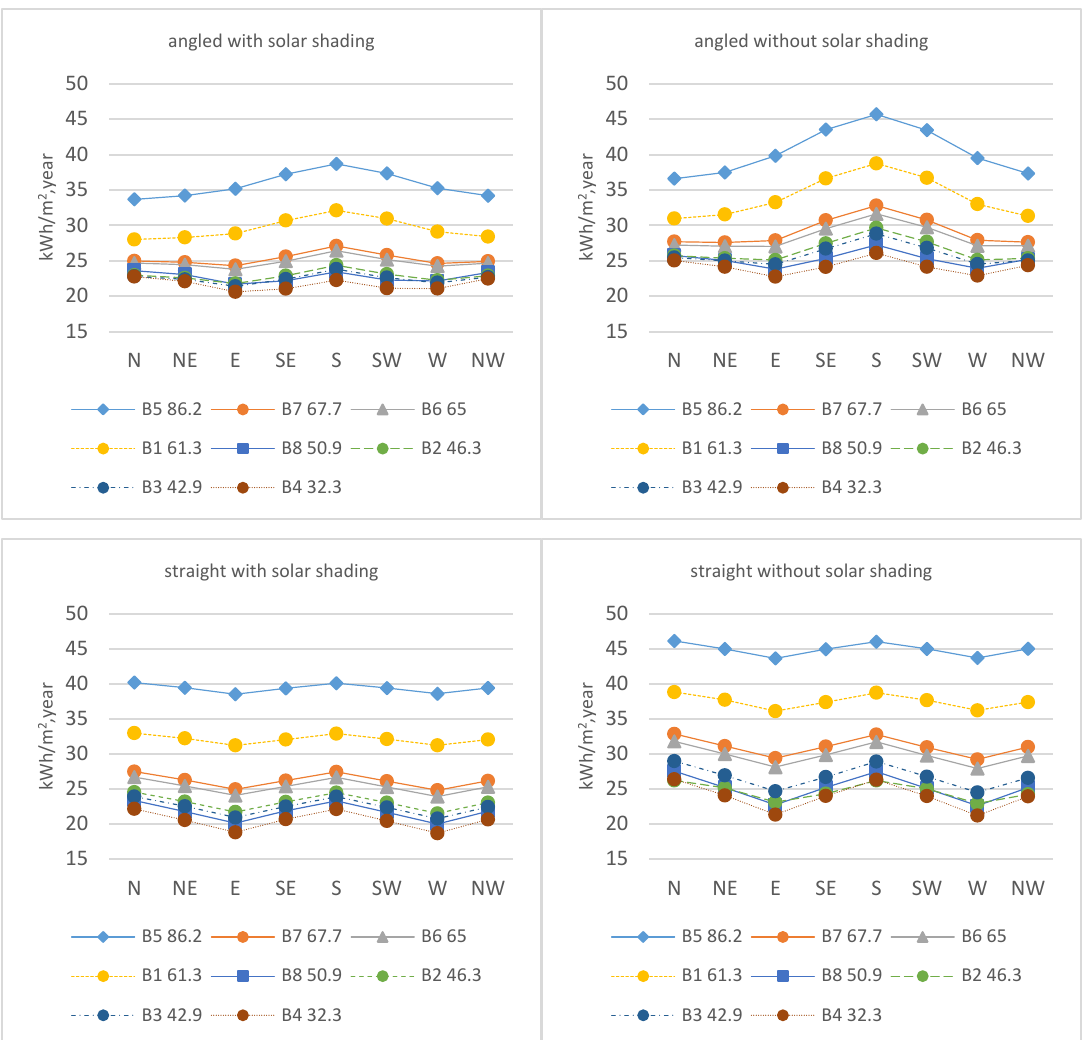
Figure 4. The total energy use for heating and cooling as a function of rotation of the office building in the city of Linköping. The eight different types of markers shows results for each different amount of internal gain used in the simulations. The lines between the markers are only for ease of interpretation. The top left is with angled façade with solar shading, the top right is with angled façade without solar shading, the bottom left is with straight façade with solar shading and the bottom right is a straight façade without solar shading.